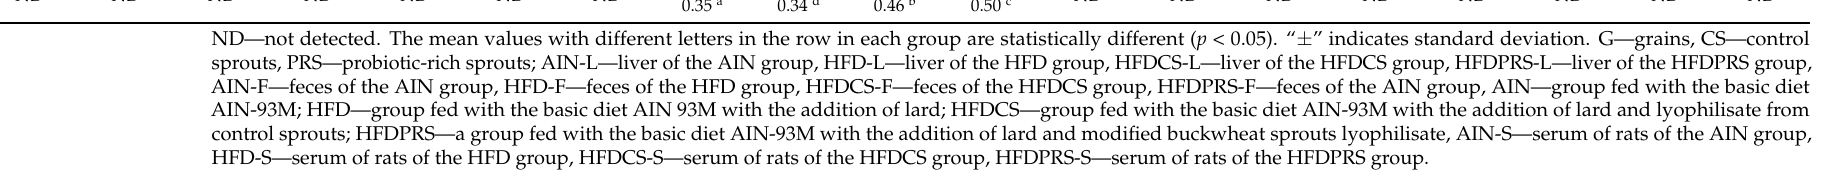
Table 5. The amount of individual groups of fatty acids (SFA, MUFA, PUFA) in buckwheat seeds (mg/g lipids) and sprouts (mg/g lipids), experimental diets